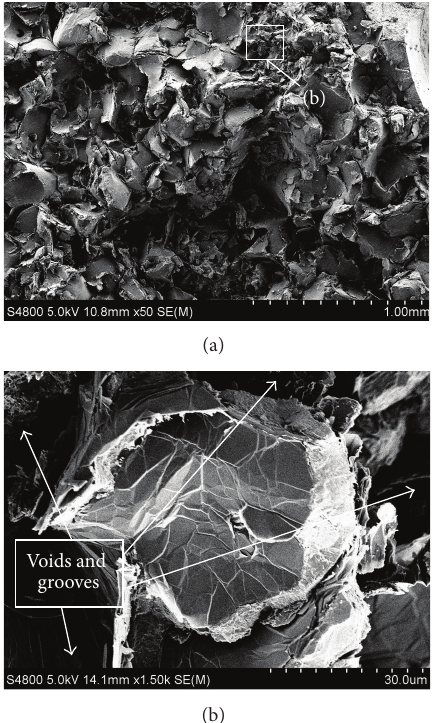
Figure 9: Fracture appearances of HT250 sample: (a) macroappear- ance SEM × 50, (b) SEM ×